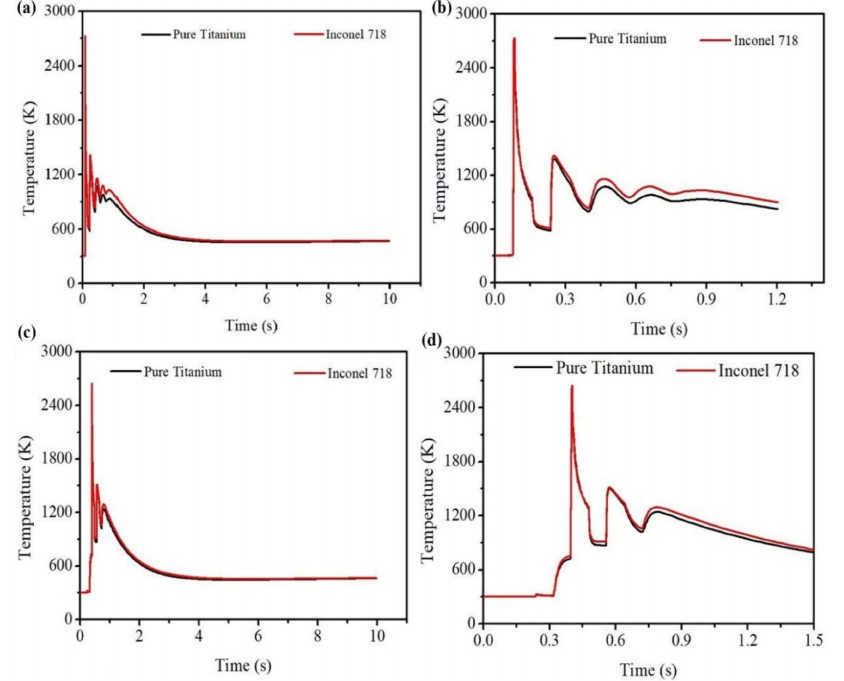
Figure 12. Time-temperature history of pure Ti and Inconel 718 alloy ( a , b ) at the centre of the 1st layer for dataset#4 and ( c , d ) at the centre of the 3rd layer for